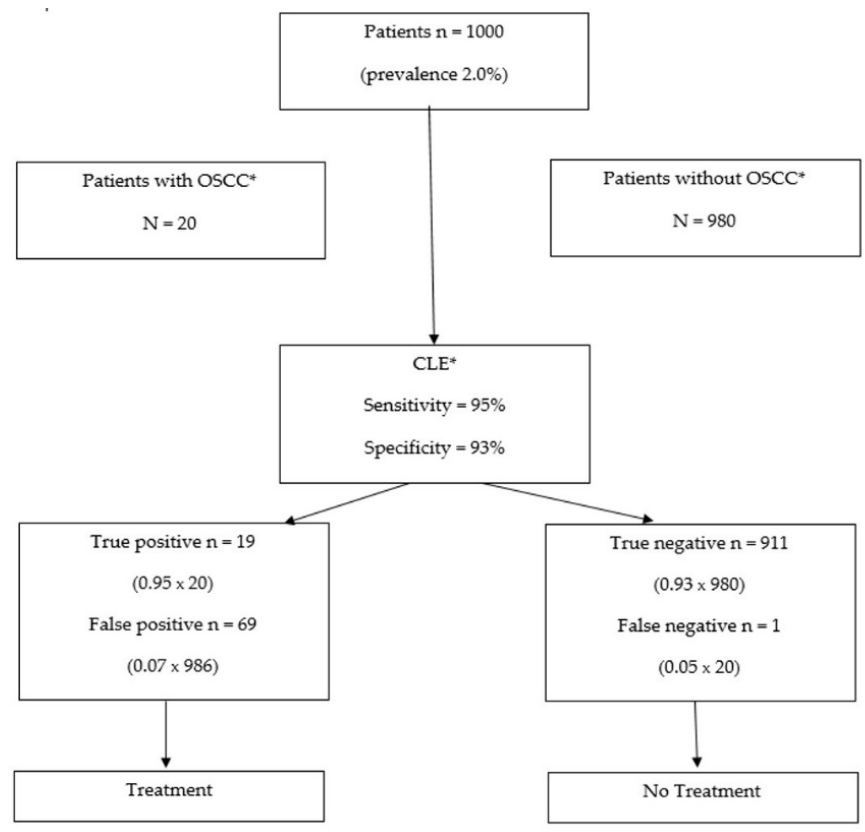
Figure 4. The use of CLE for OSCC diagnosis in a cohort of 1000 subjects. CLE would lead to 88 patients being treated, of which 69 would not need to be treated; 911 patients would not receive treatment, of which only one would have demanded treatment. * Abbreviations: OSCC—Oral Squamous Cell Carcinoma; CLE—Confocal Laser Endomicroscopy.